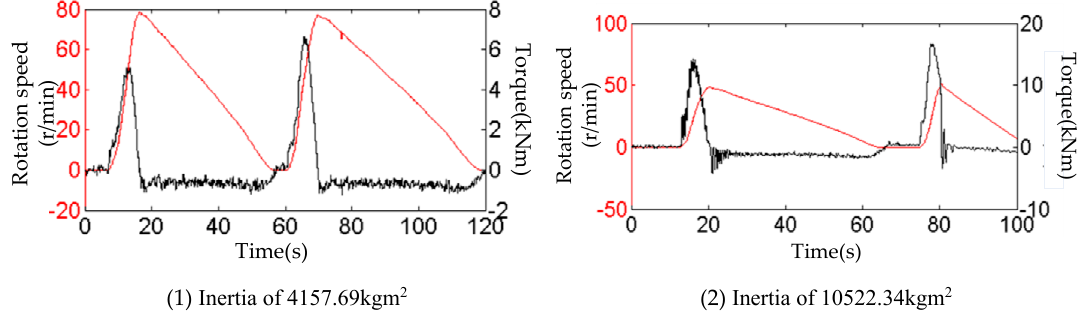
Figure 23. Calibration test results under equivalent inertia of 4157.69 kg · m 2 and 10,522.34 kg · m 2 .